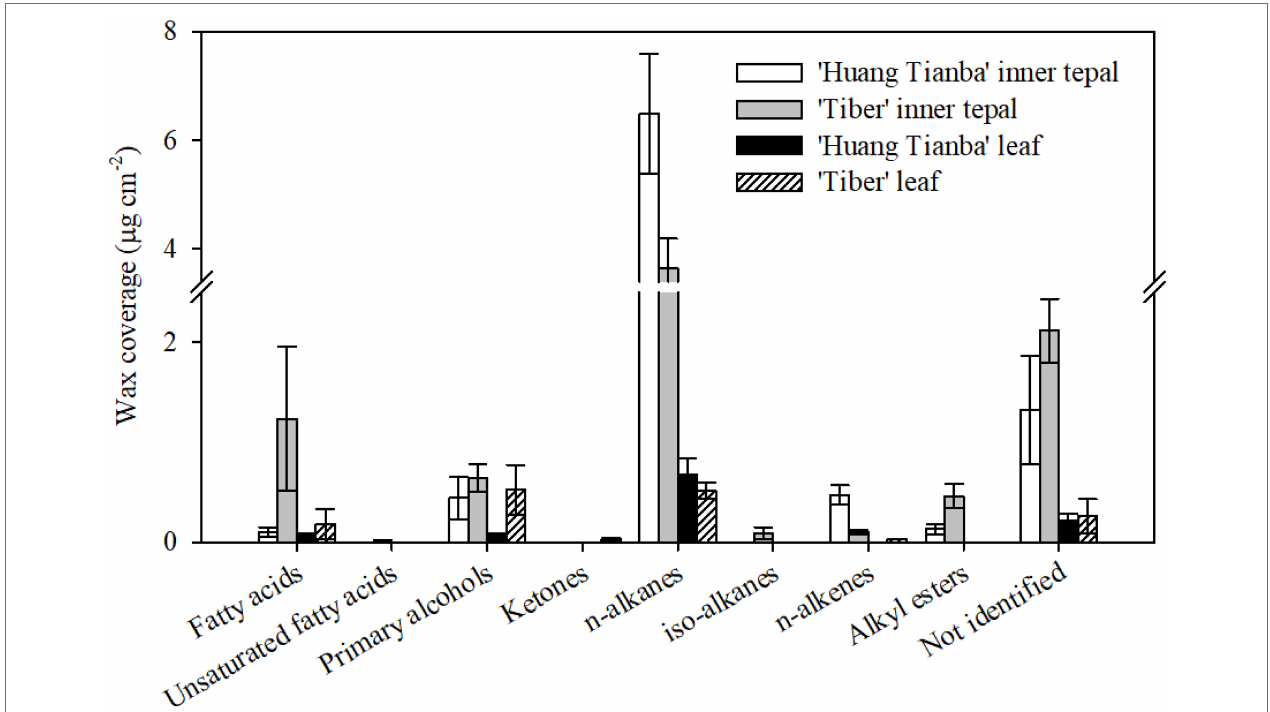
FIGURE 6 | Chemical composition of cuticular waxes on the tepals and leaves of the Lilium cultivars ‘Huang Tianba’ and ‘Tiber’. Data are presented as the mean ± standard deviation ( n =